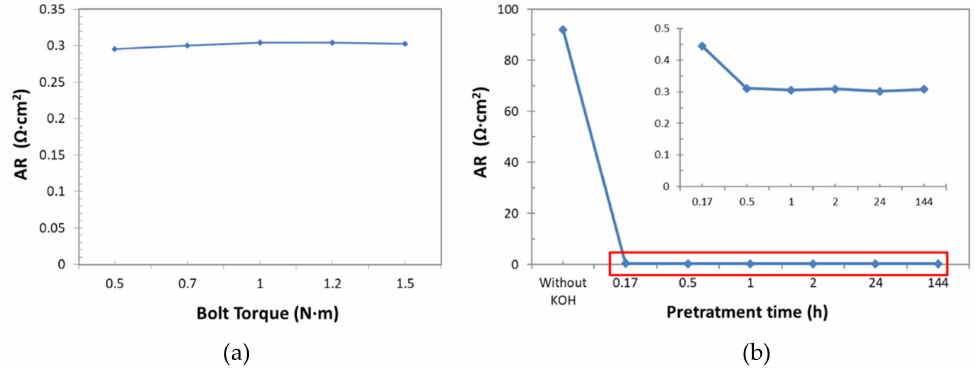
Figure 15. Influence of Zero-Gap Method parameter over area resistance (AR) determination: ( a ) Bolt Torque ( b ) Pre-treatment time.